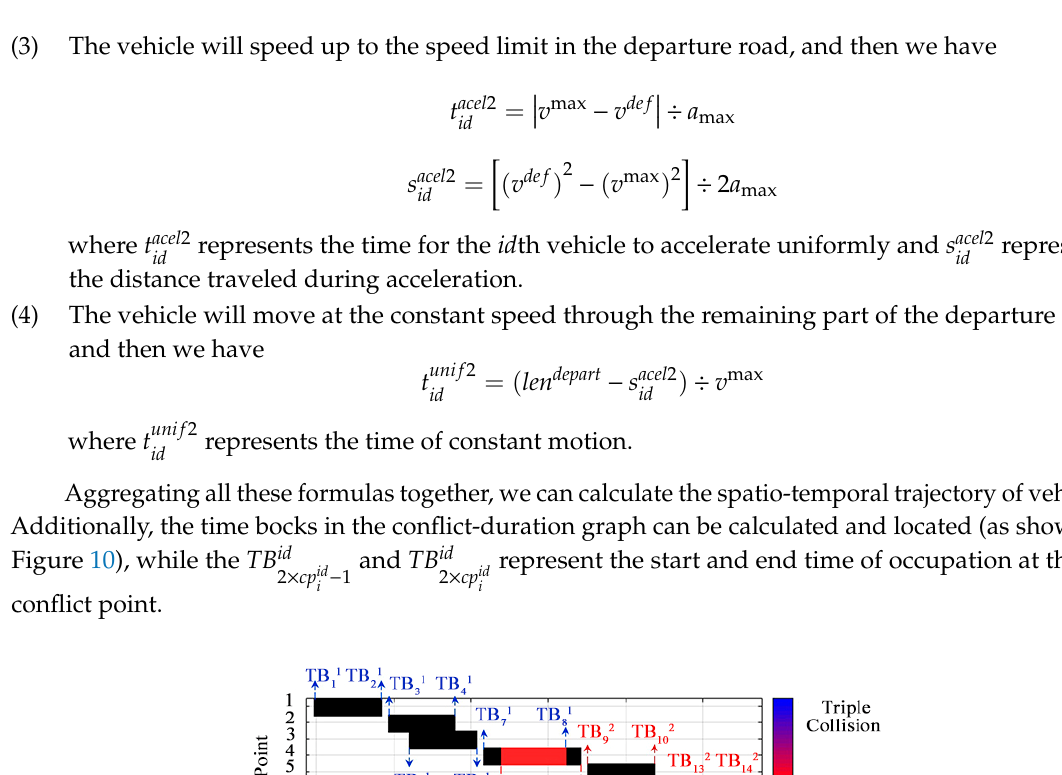
represent the start and end time of